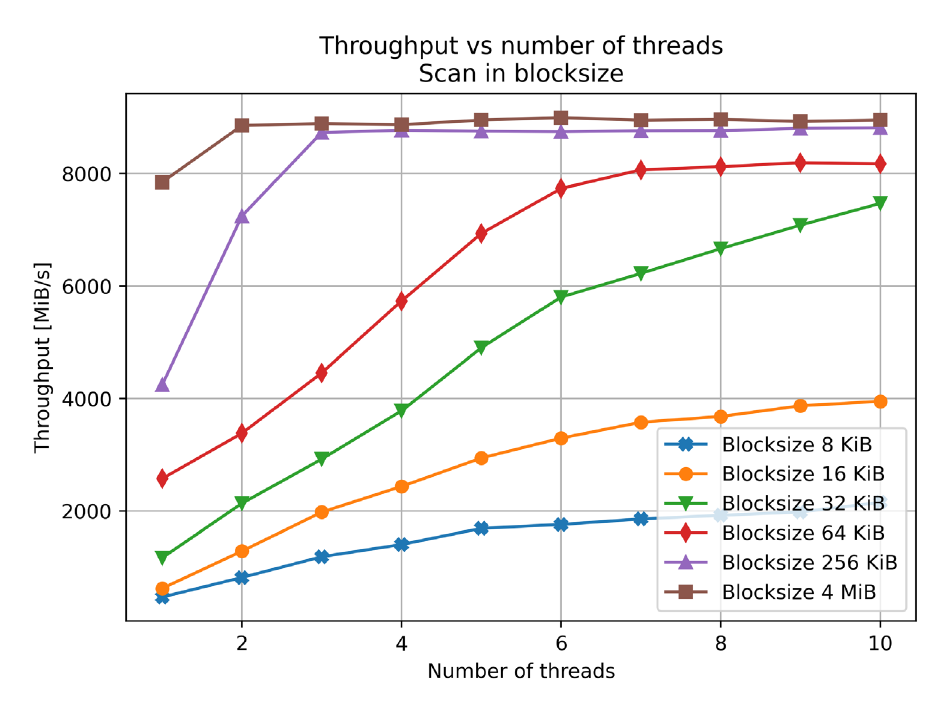
Figure 1. Write throughput as a function of the block size ranging from 4 KiB up to 32 MiB. The system reaches the maximum bandwidth with a block size of around 8 MiB. Figure 2. Write throughput as a function of the number of threads ranging from 1 to 10. A scan in block size has also been performed from 8 KiB up to 4